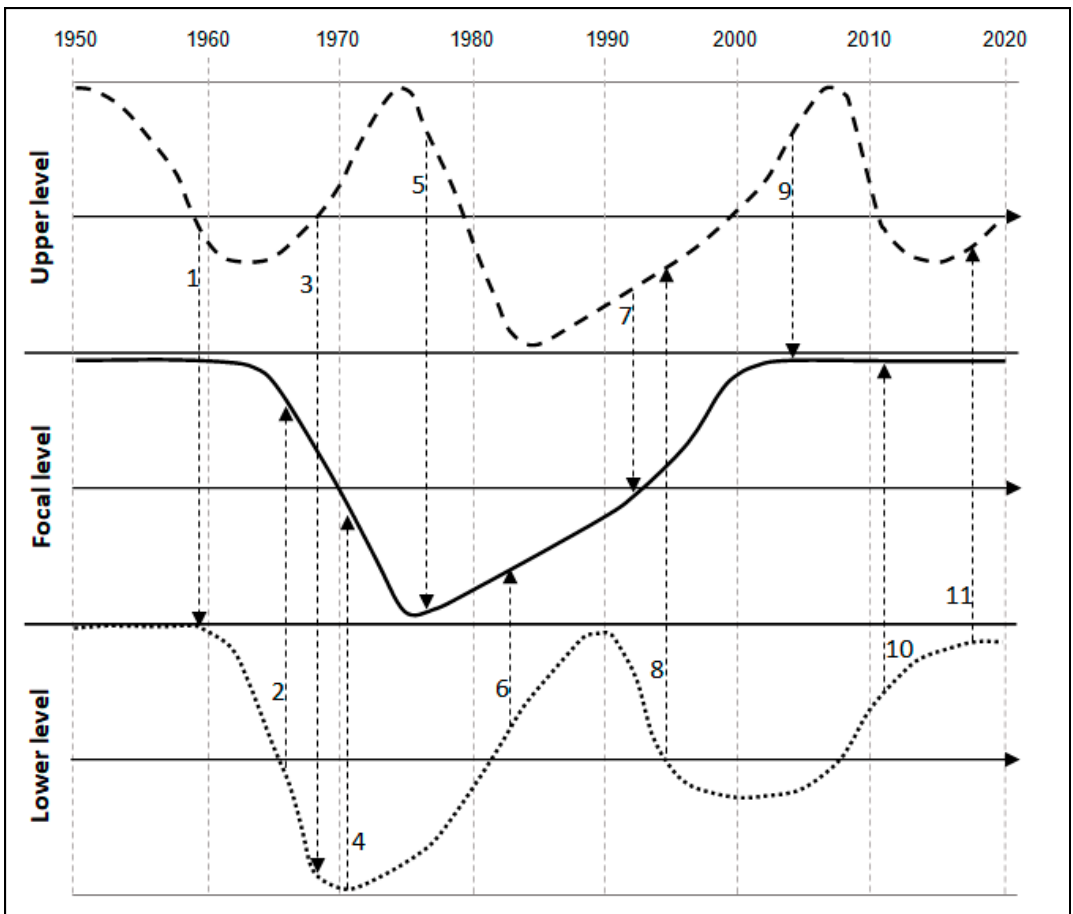
Figure 4. The adaptive curves that illustrate changes and cross-scale interactions in the social-ecological system assessment of La Marjaleria. The numbers beside the vertical arrows indicate the order of interactions between levels.